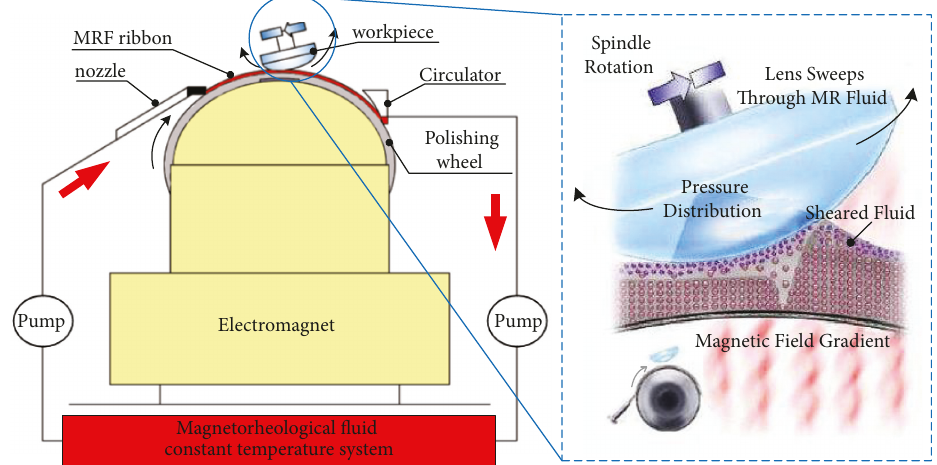
Figure 24: Magnetorheological finishing